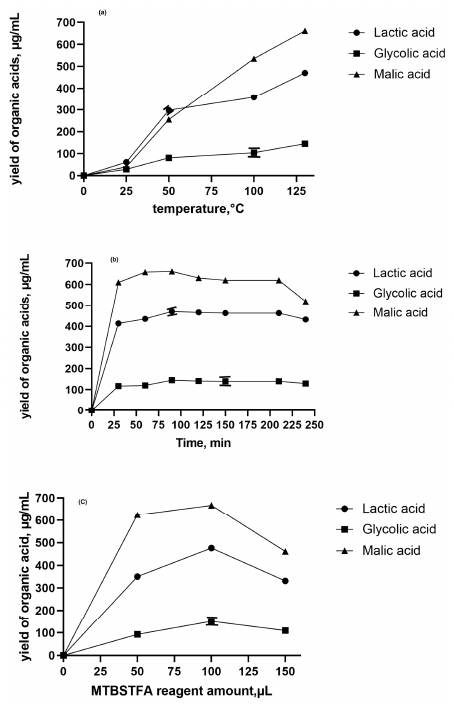
Figure 2. The effect of operation parameters on derivatization reaction: (the yield of lactic acid—62 µg/g, glycolic acid—40 µg/g and malic acid—30 µg/g in the example sample). Temperature ( a ), Time ( b ), derivatization agent (MTBSTFA) ( c ). Results are expressed as means ± standard error ( n = 6).